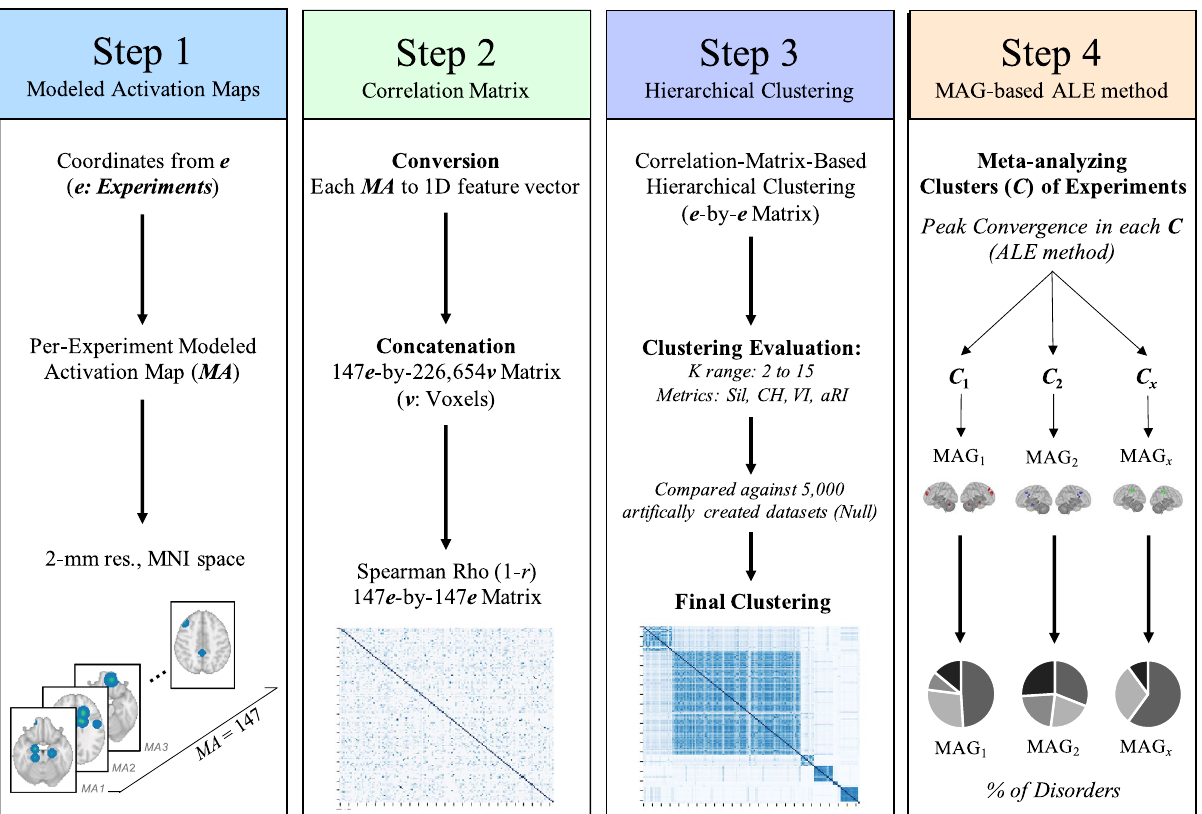
Figure 1. Workflow of the current study. Step 1: Creation of a MA map for each experiment, weighted by sample size. Step 2: Pairwise Spearman Rho correlation was performed between every MA map. Step